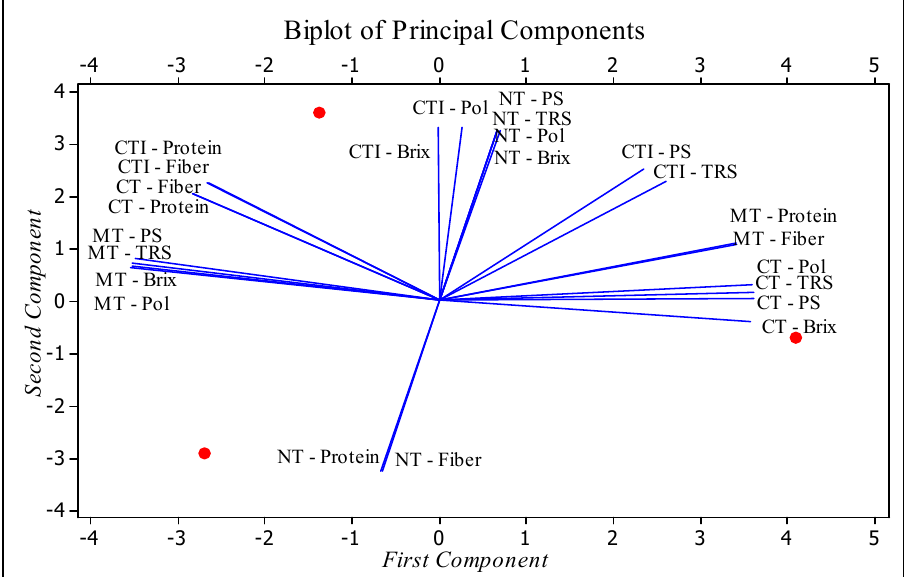
Figure 4. Perceptual map of broth quality: multivariate principal component analysis (PCA) method.